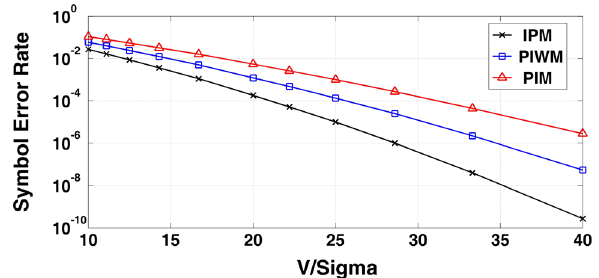
Figure 6. Symbol-error rate for IPM, PIWM and PIM (symbol rate = 5 MS/s , T r = T f = 4 ns).